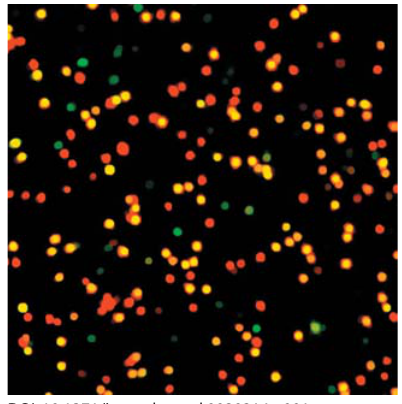
Figure 1. CD4 Cell Measurement Using a Prototype Microchip Counting Method This is a digital image of whole blood from a fi ve-month-old male infant from Botswana with an absolute CD4 count of 2,098 cells/ ml and a CD4 percentage of T cells of 0.39, obtained using a prototype method for low-cost CD4 count monitoring. CD4 + T cells are yellow. Also visualized are monocytes (green) and CD8 + T cells (red). (Photo courtesy of the authors of